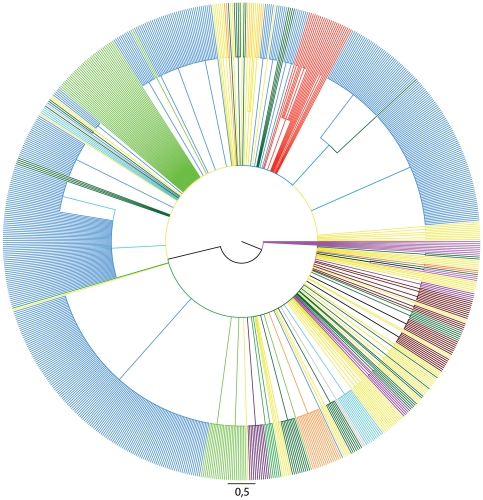
Relationships between the subtype D sequences inferred using maximum likelihood phylogeny (GenBank deposited pol sequences).Country-specific sequences are marked with the same color: red – Poland, blue – Uganda, green – Tanzania, yellow – Europe (except Poland), brown – Cameroon, magenta - Senegal, cyan- Sudan, dark green – other African countries, violet – South America, grey – Asia, orange – North America.